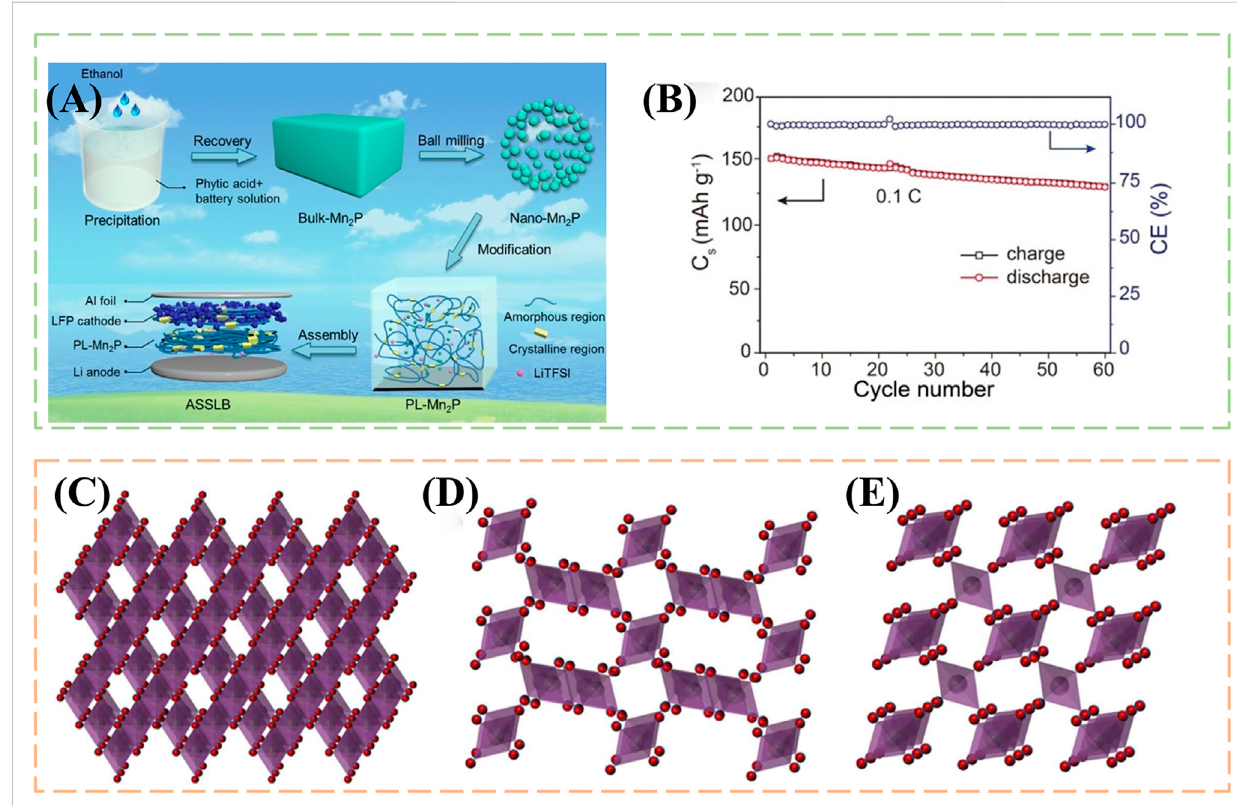
FIGURE 3 (A) Schematic of recycling process and assembly of Li |PL-Mn 2 P| LiFeO 4 batteries; (B) Cycling performance of LiFePO 4 |PL-Mn 2 P5|Li cell at 0.1 ° C; Crystal structure of (C) λ -MnO 2 , (D) γ -MnO 2 and (E) β -MnO 2 . Purple sphere, Mn; Red spheres,